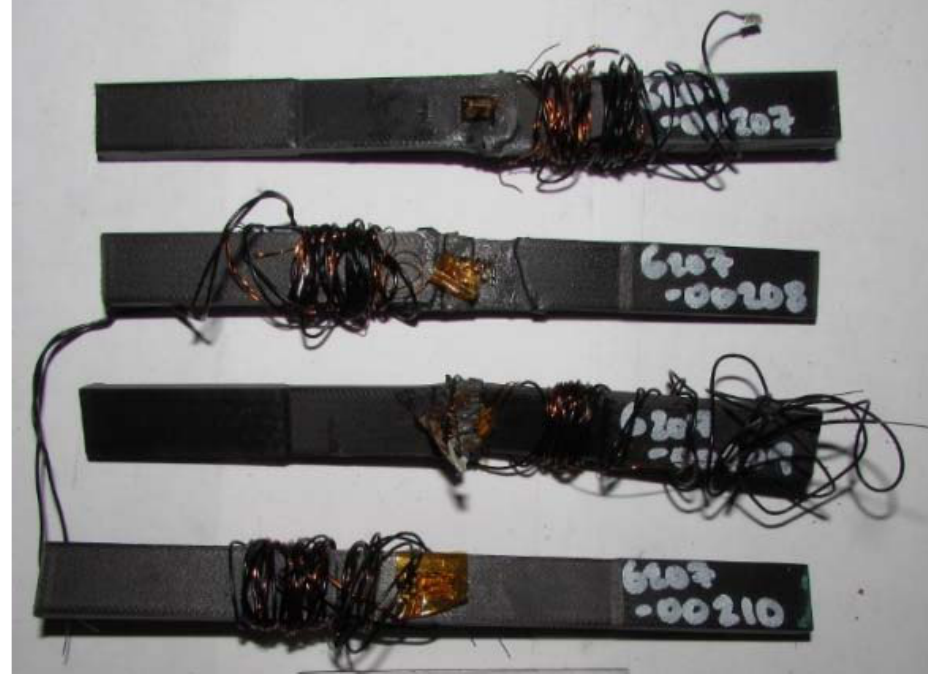
Figure 4. Failed test coupons after the RTD multifunctional Compressive ‐ Electrical test.